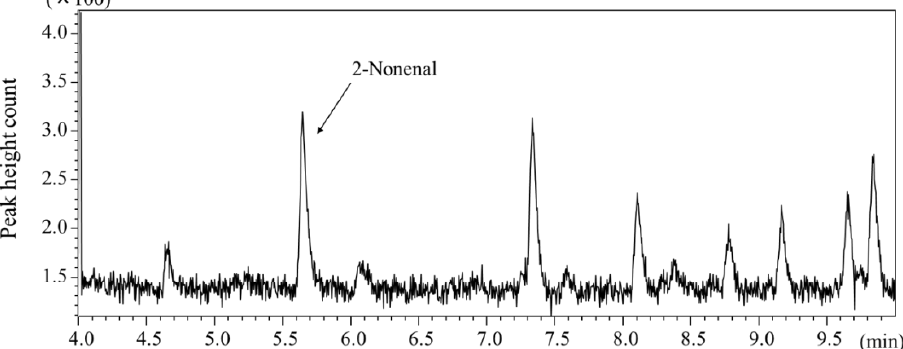
Figure 6. Total ion chromatogram of skin emission sample (forehead, male in their 30s).